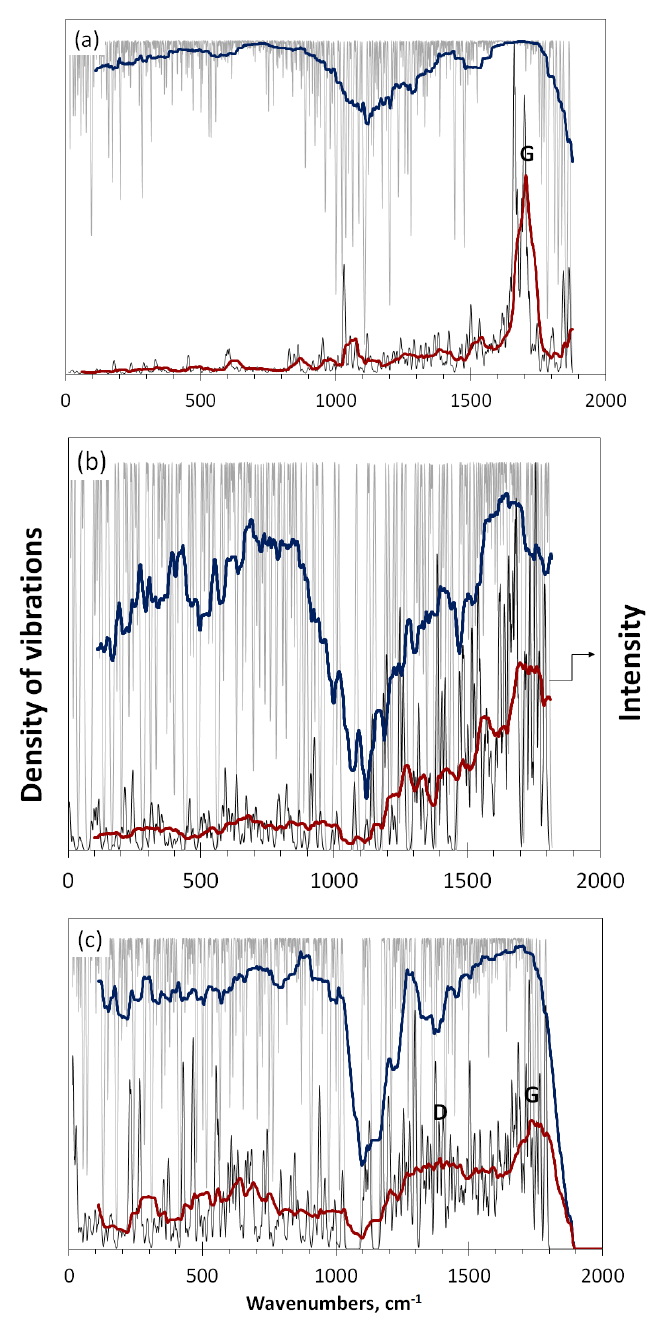
Figure 1. The Raman spectra of the DTs related to the graphene domains. ( a , b ) One-layer hydrogenated (9, 9)) and bare (5, 5) domains, respectively; ( c ) Two layers of the hydrogenated (5, 5) domain. Raman spectra and DOVs are accompanied with 100-point trendlines. A detailed description of the DT structure can be found in [13]. UHF AM1 calculations.